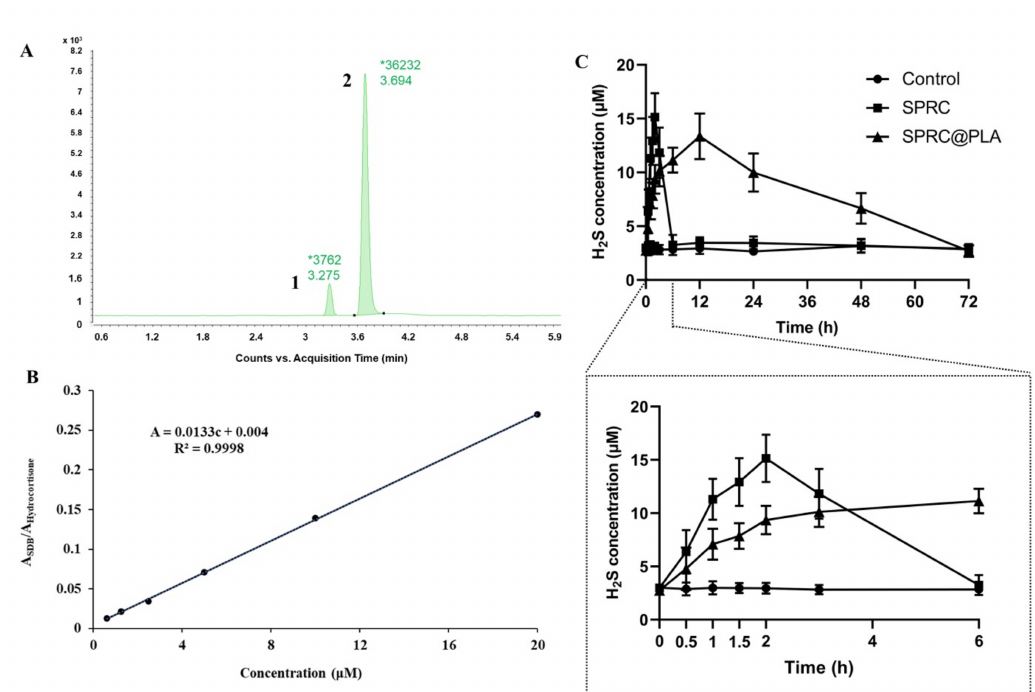
Figure 5. The detection of endogenous H 2 S via LC-MS. ( A ) The chromatography of SDB, peak 1/SDB, peak 2/hydrocortisone (internal standard); ( B ) the calibration curve of SDB in different concentration (0.625~20 µ M); ( C ) the 3-day endogenous H 2 S concentration changes in plasma after a single injection of SPRC or SPRC@PLA. Dosage of 100 mg kg − 1 was calculated according to rats’ body weight ( n = 3, mean ± SD).